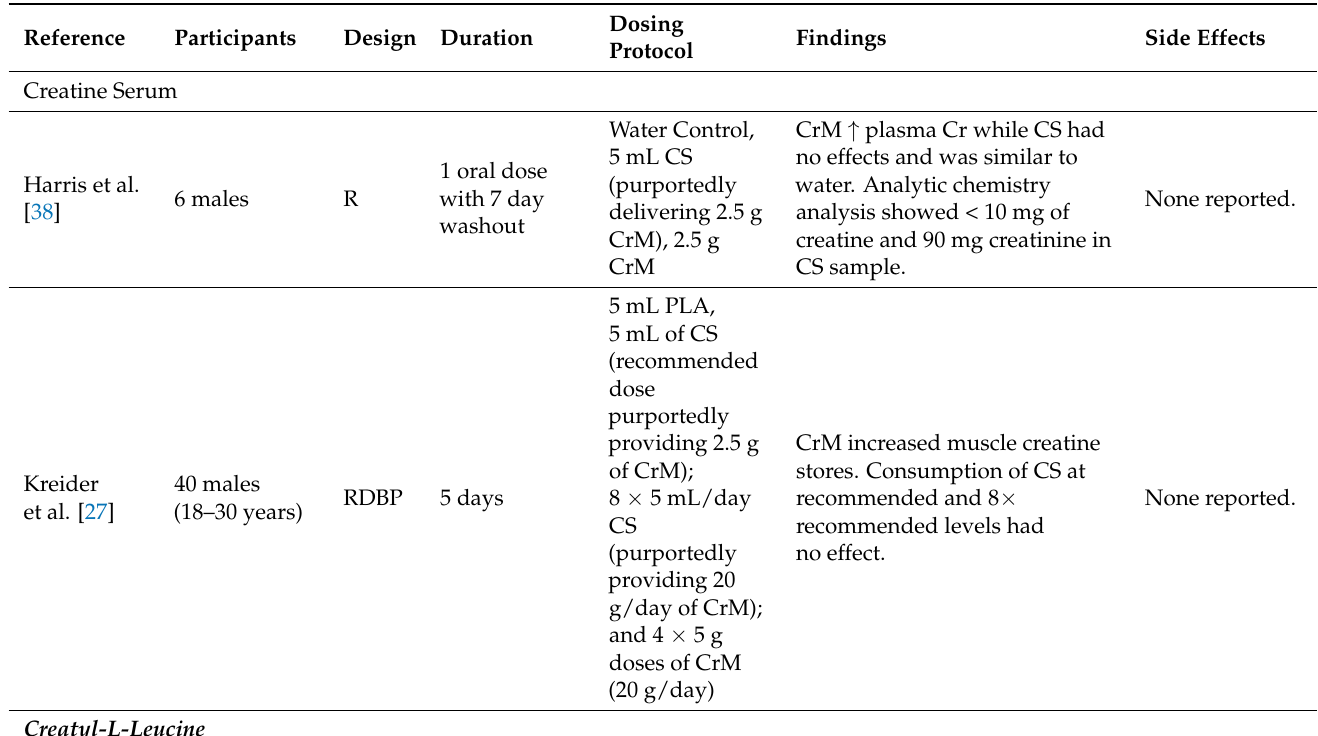
Creatine containing compounds that have no evidence of bioavailability, efficacy, and/or